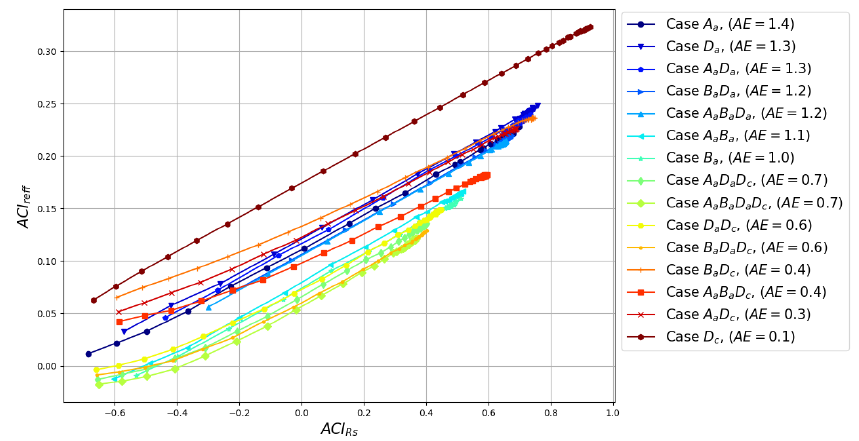
Figure A9. Relation between the ACI ref f with the ACI Rs for different cases according to the